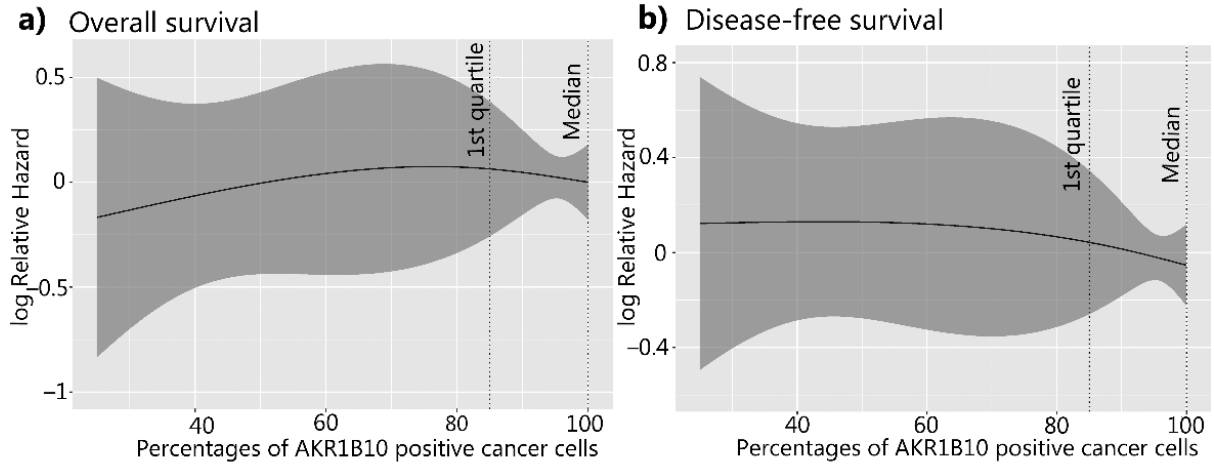
Figure 7. Overall survival and disease-free survival of patients with HGSC in relation to AKR1B10. ( a ) Overall survival ( p = 0.72) and ( b ) disease-free survival curves ( p = 0.82). The X-axis represents the percentages of AKR1B10-positive cancer cells. The Y-axis represents the hazard ratio for death ( a ) and disease relapse ( b ). AKR1B10: aldo-keto reductase family 1 member B10; HGSC: high-grade serous ovarian cancer.